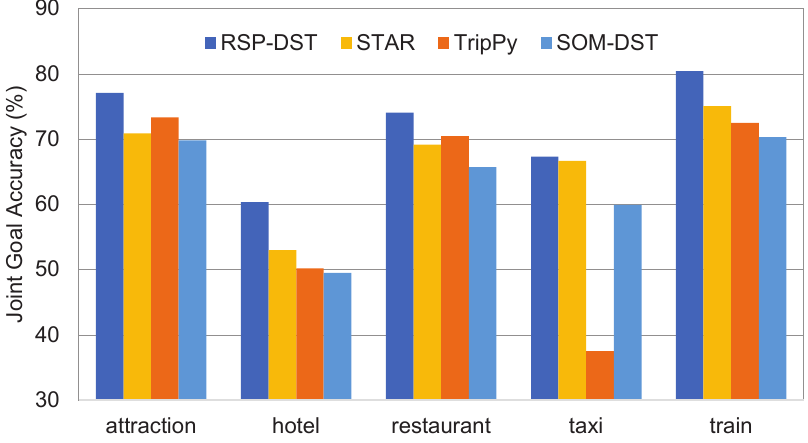
Figure 5. Domain-specific joint goal accuracy on the test set of MultiWOZ